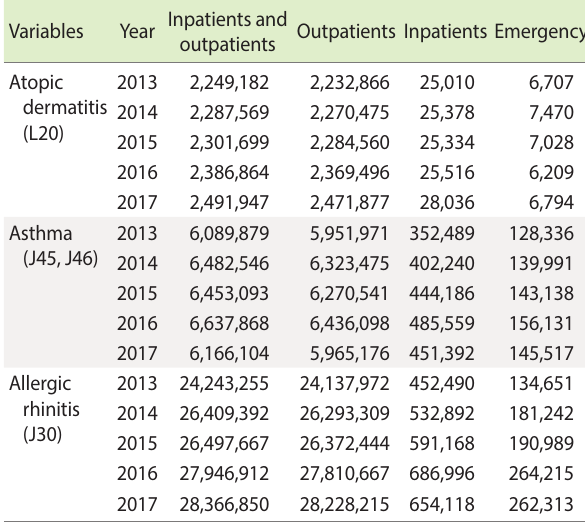
Table 2. Total number of patients in the yearly population and in the patient